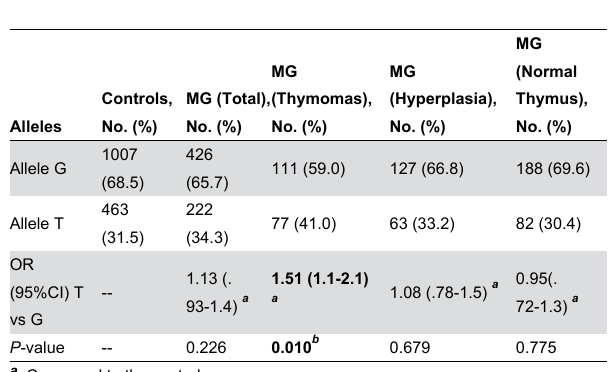
Table 2. allele frequencies in Myasthenia Gravis patients and Controls.